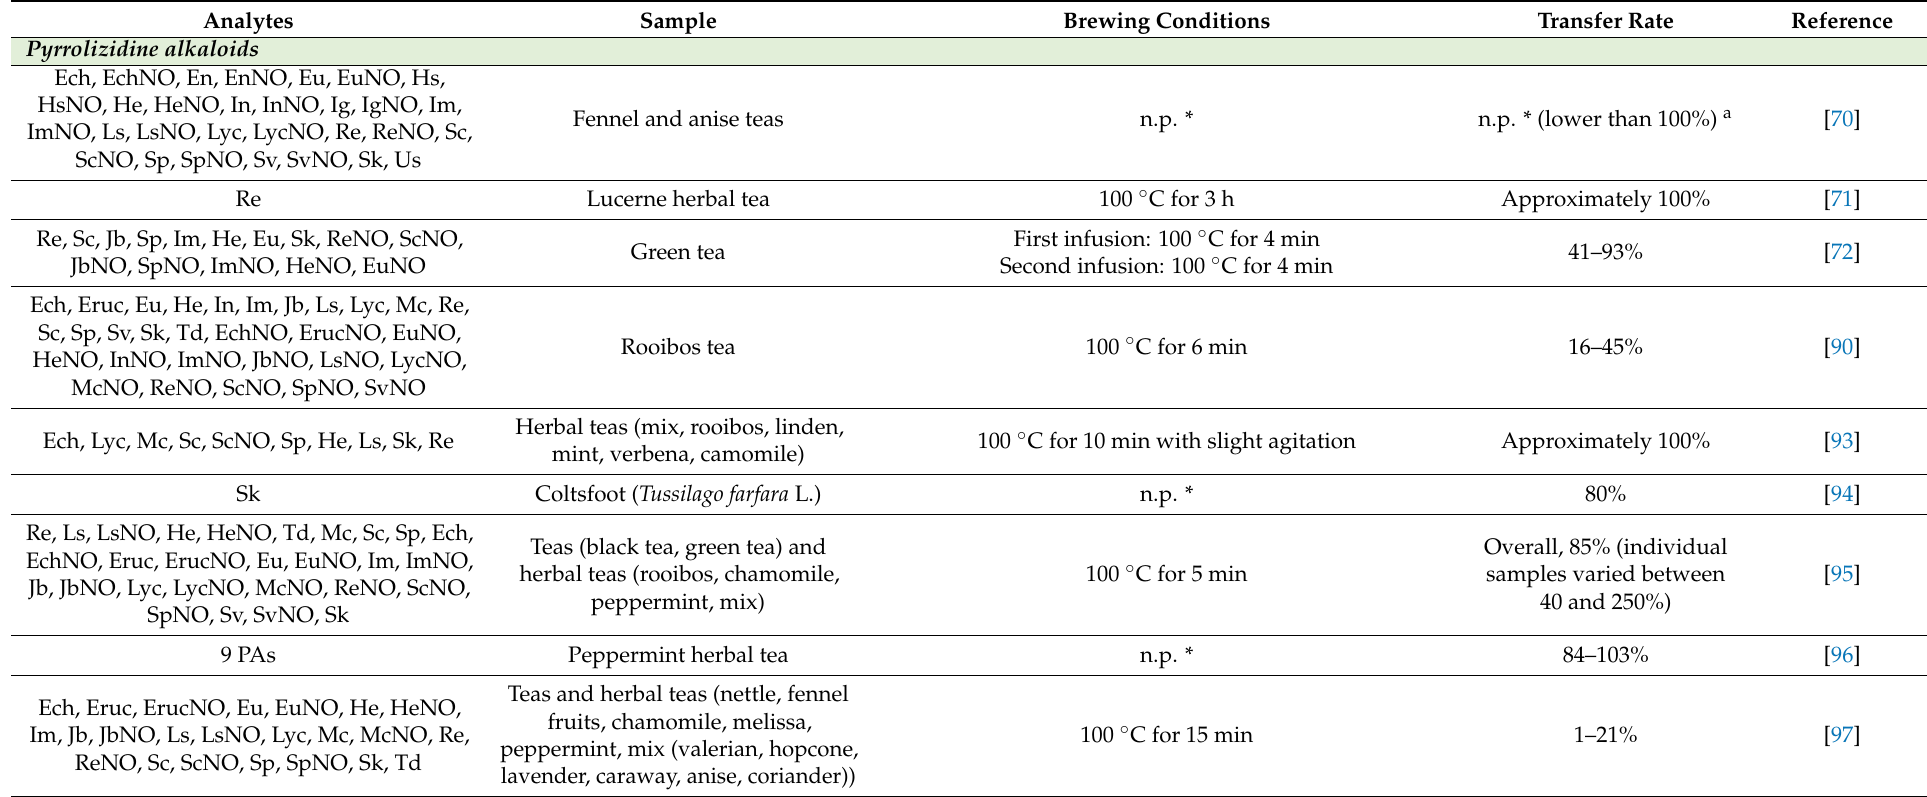
Table 3. Transfer rate of pyrrolizidine, tropane and alkaloids during brewing processes according to literature